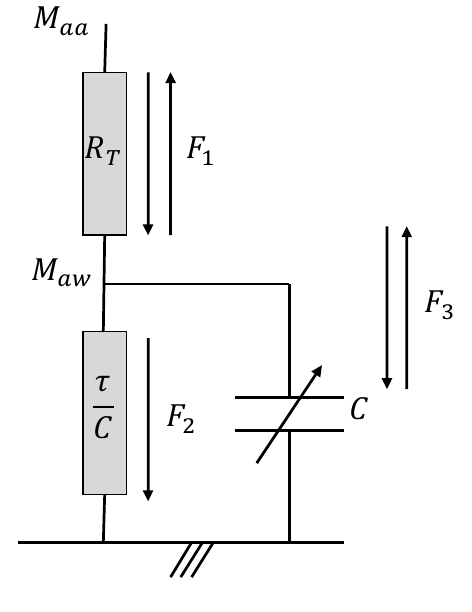
Fig. 2. Electrical analogy for methanol adsorp- tion/desorption/degradation processes. F 1 represents the net methanol flux exchange, F 3 represents the adsorption/desorption of methanol in water films (represented by the capacity: C ), F 2 represents the methanol degradation (represented by the resistance: τ/C ), M aw and M aa represent the methanol concentration in the air at the water film surface and in the atmosphere, respectively, and R t represents the gas-phase resistance to the methanol transfer in the surface boundary